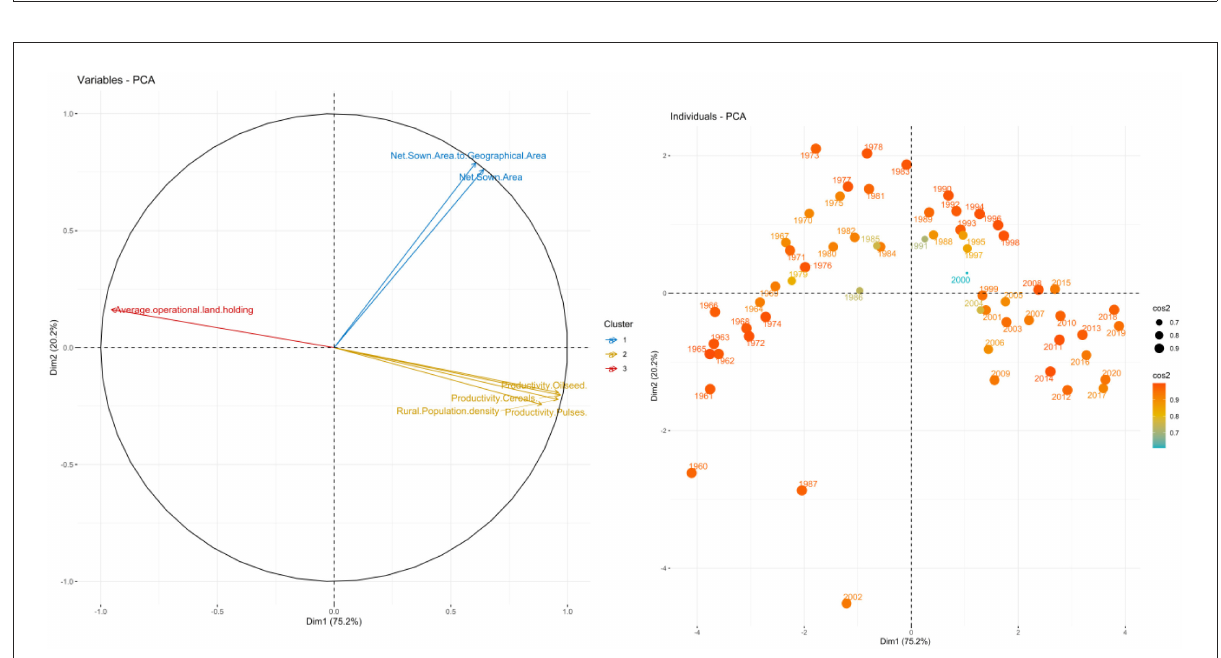
FIGURE5 Biplot between PC1 and PC2 and Principal Scatter plot of past six decades under Sensitivity indicators.